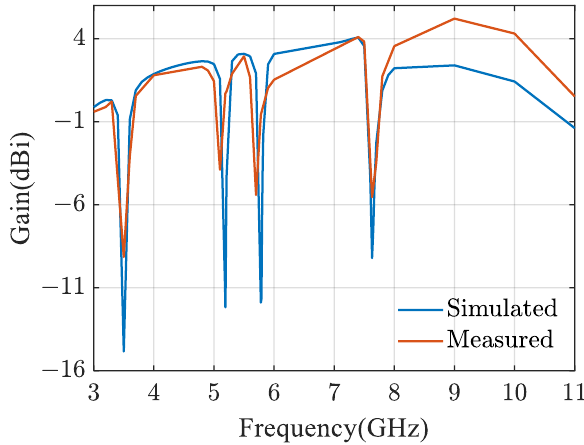
Figure 16. Gain of the proposed antenna with notched bands.